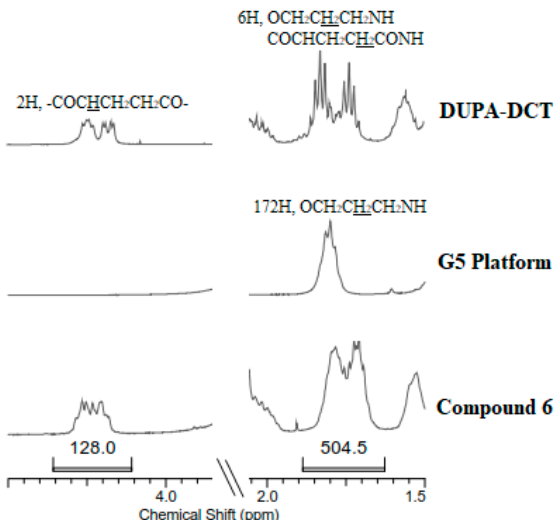
Figure 1. 1 H NMR spectra of DUPA-DCT, G5 Platform, and 6 in the distinctive region for monitoring reaction of the DCT with the deprotected G5 dendrimer. The theoretical integration value of 6, which appeared at 1.75 ppm, is supposed to be 556.